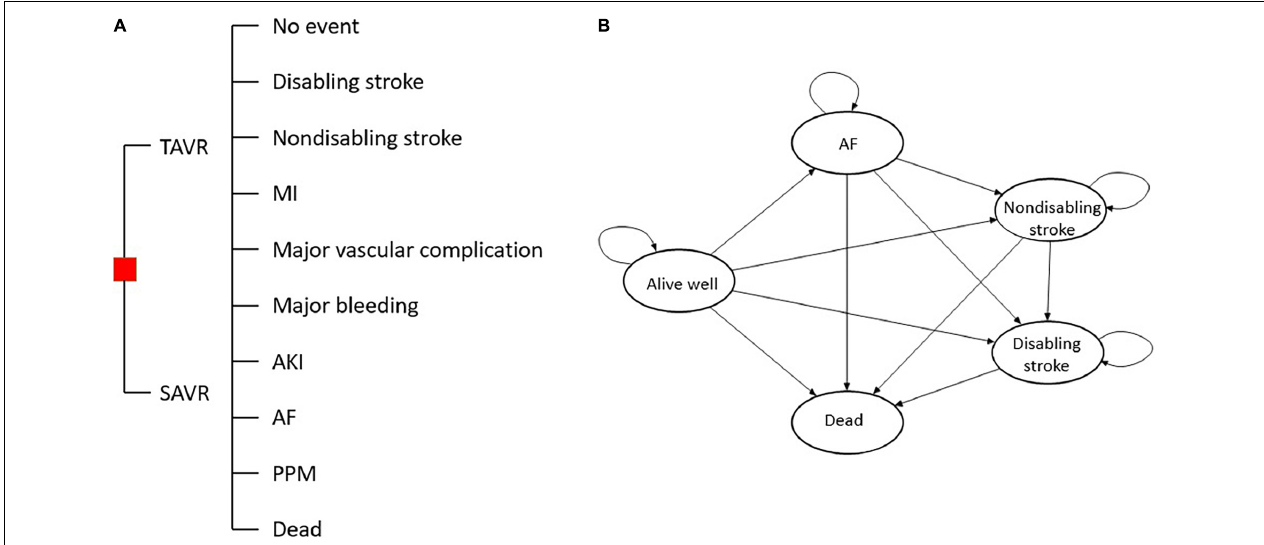
FIGURE 1 | Decision tree (A) and state transition diagram of the Markov model (B)